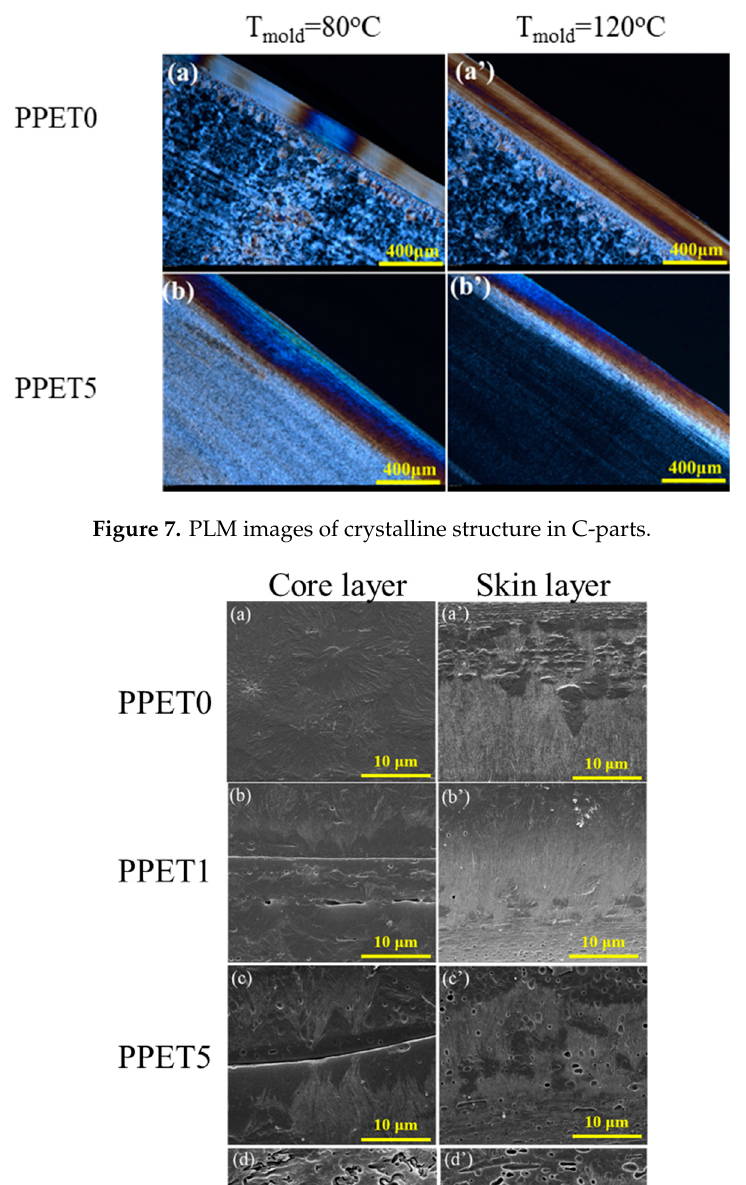
Figure 6. Polarized Light Microscope (PLM) images of crystalline structure in M-parts.